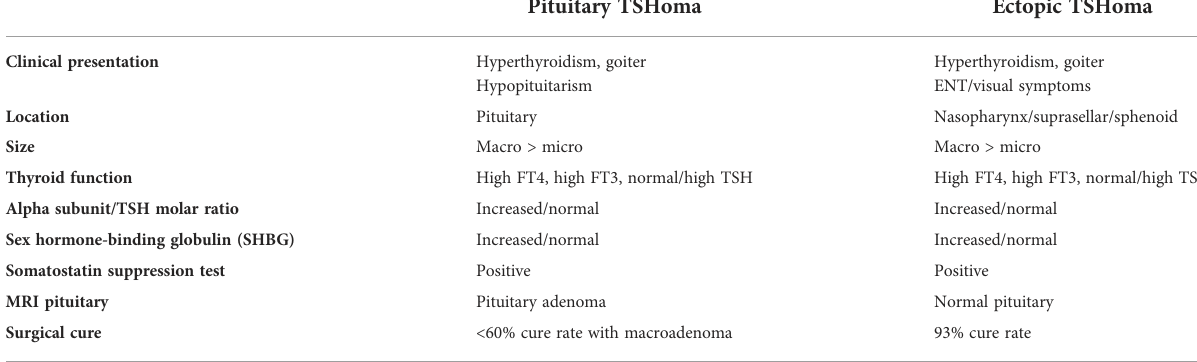
TABLE 2 Clinical, biochemical, and radiological characteristics of pituitary and ectopic